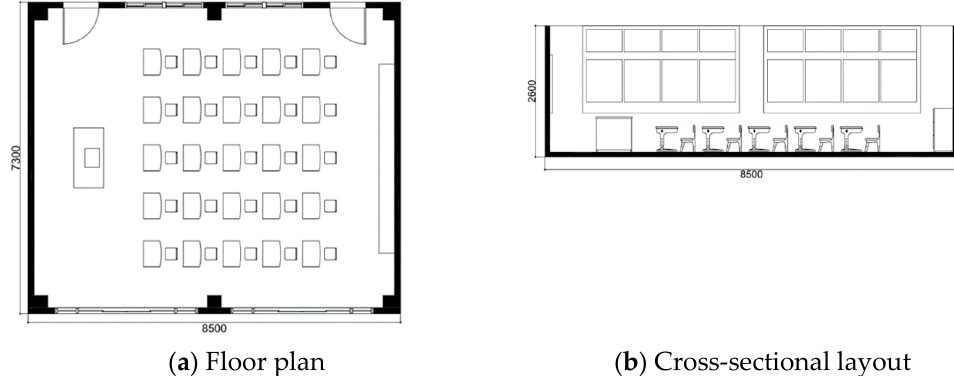
Figure 3. Floor plan and cross-sectional layout of standard elementary school classroom in Korea (unit: mm).